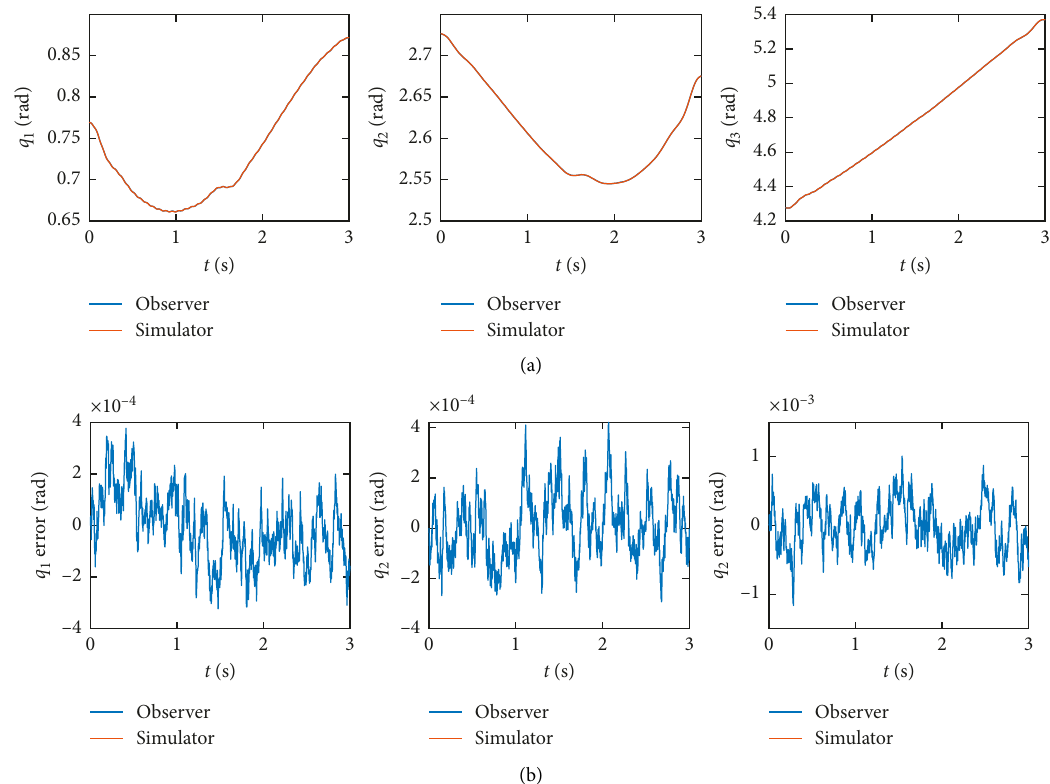
Figure 6: Estimated angular positions of the actuated links (a) and estimation errors